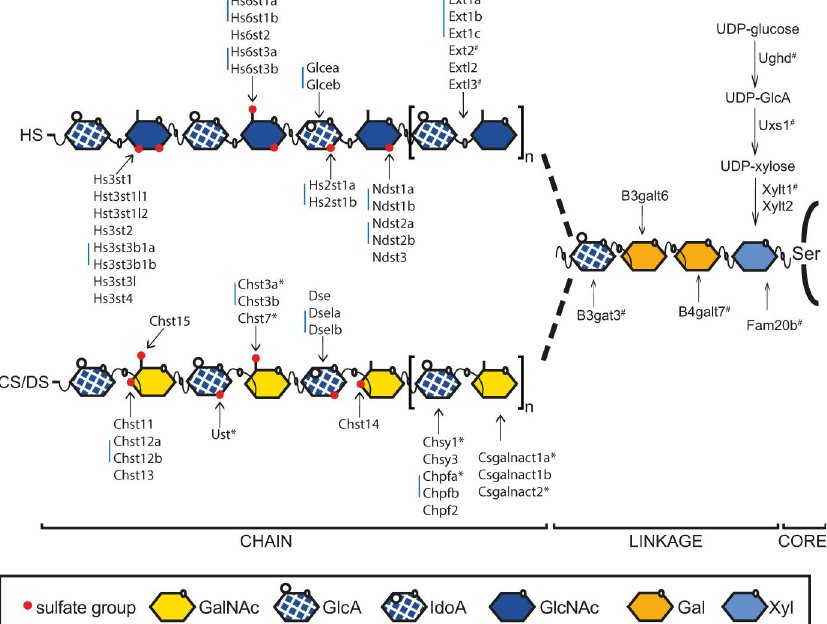
Fig 1. Heparan sulfate (HS) and chondroitin/dermatan sulfate (CS/DS) biosynthesis in zebrafish. HS and CS/DS chains are attached to serine (Ser) residues of the core protein. The first four monosaccharides form the linkage region of both HS and CS/DS. Extl3 initiates HS polymerization, while Csgalnact1a and Csgalnact2 perform this function in CS/DS polymerization. Elongation of HS is carried out by Ext enzymes, while Chsy and Chpf enzymes polymerize the CS/DS chain. The first modification of HS is carried out by Ndst enzymes, replacing an N -acetyl groups of GlcNAc residues with an N -sulfate group. Glcea and Glceb epimerize GlcA into IdoA in HS, while Dse, Dsela and Dselb are responsible for this modification in DS. Hs2st enzymes add a sulfate groups to the IdoA C-2 position of HS and Hs6st and Hs3st enzymes add sulfate groups to the GlcNAc or GlcNS residues. Ust adds a sulfate group to the hexuronic acid C-2 position of CS/DS while Chst11, Chst12a, Chst12b, Chst13 and Chst14 are GalNAc 4-O-sulfotransferases while Chst3a, Chst3b, Chst7 and Chst15 are GalNAc 6-O-sulfostransferases. Blue bars indicate two or three zebrafish genes orthologous to a single mammalian gene. Ndst3 in zebrafish is a single gene orthologous to two mammalian genes (NDST3 and NDST4). # Indicates previously published mutant zebrafish alleles while � indicates the targeted mutations reported in this study. Xyl: xylose, Gal: galactose, GlcNAc: N -acetylglucosamine, IdoA: iduronic acid, GlcA: glucuronic acid, GalNAc: N